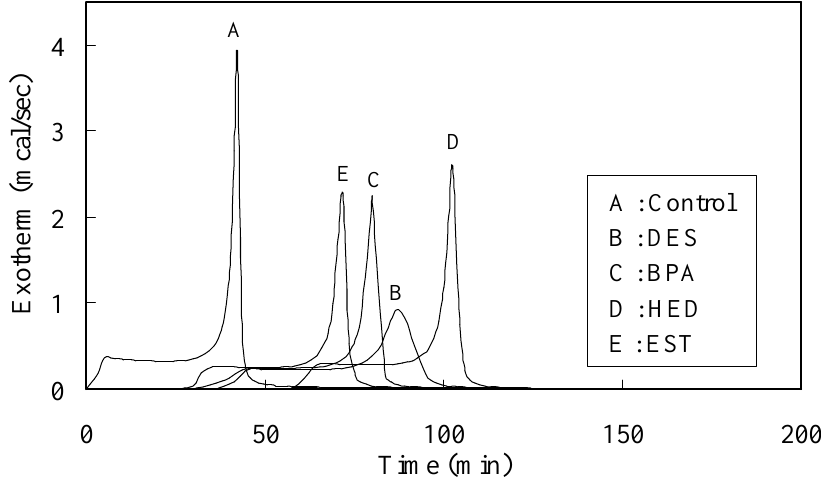
Figure 2 . Time-exothermic curves for the polymerization of MMA with 1.0 mol% AIBN in the presence of 0.1 mol% additives. MMA, 9.4 mol/L; AIBN, 1.0 mol%; at 70 °C. A, control; DES, diethylstilbestrol; BPA, bisphenol A; HED, 2-hydroxyestradiol; EST, estrone.